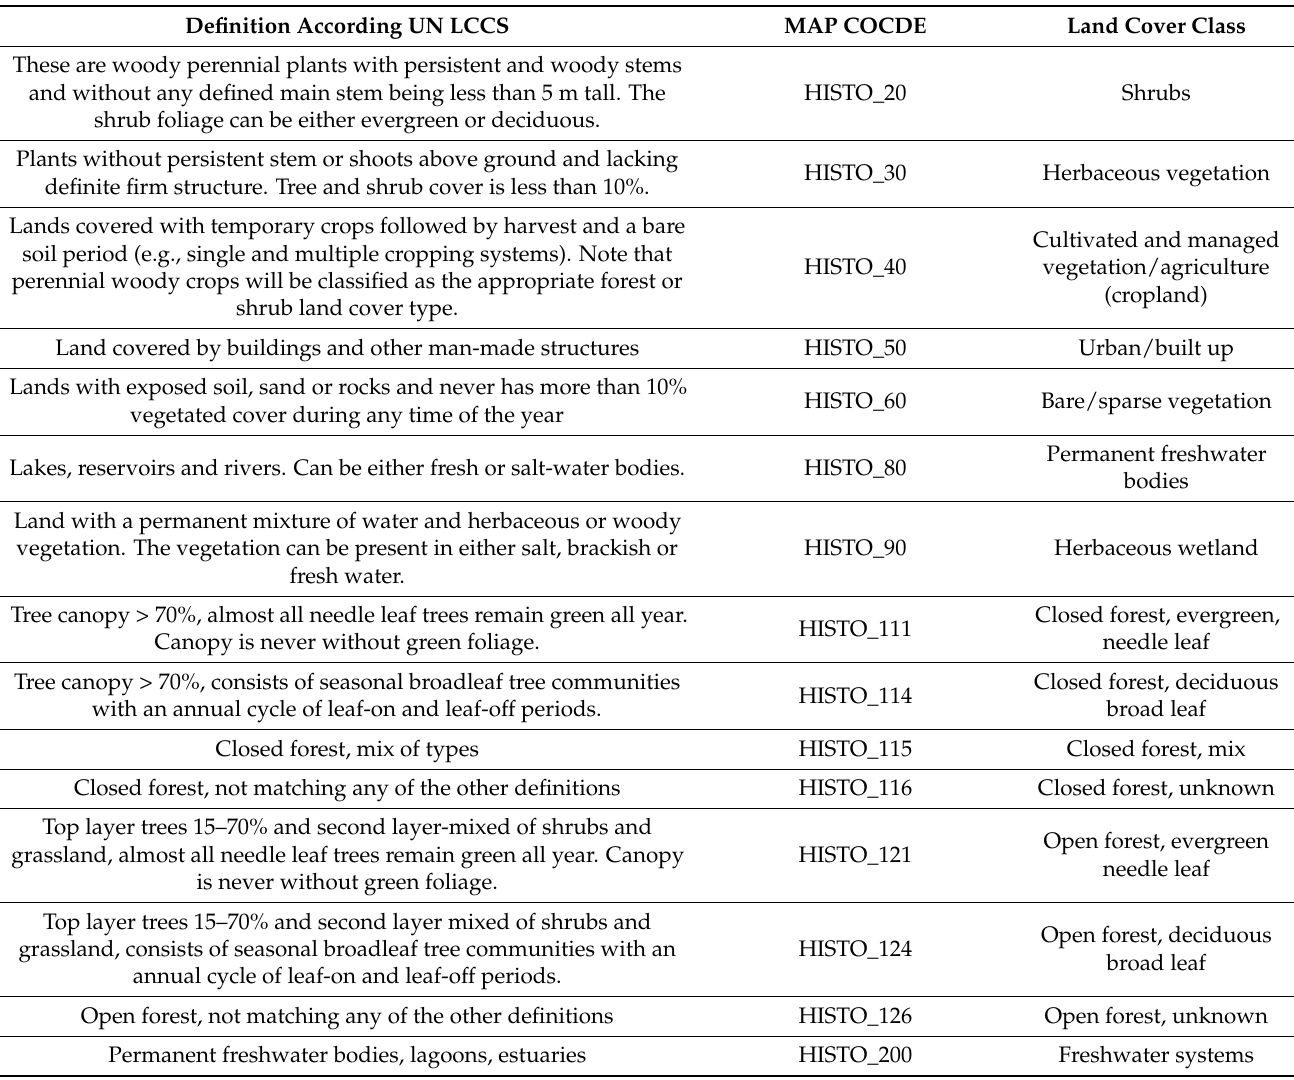
Table 1. List of the CORINE land cover variables used for both the Anoxia orientalis presence points and the random points used for the analyses in the present